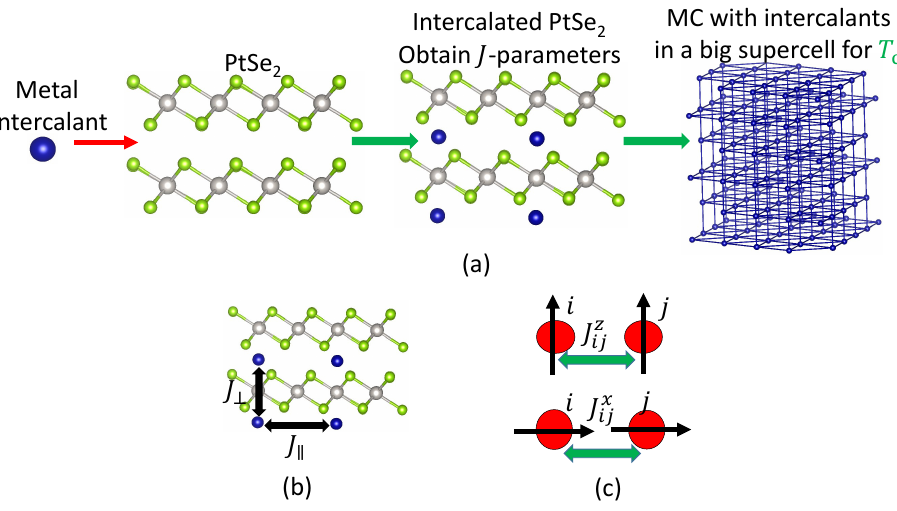
Figure 1. ( a ) The magnetic ions are intercalated in PtSe 2 . ( b ) The exchange parameters in the in-plane ( J (cid:107) ) and in the out-of-plane ( J ⊥ ) direction. ( c ) The J parameters between spins i and j oriented in the in-plane direction ( J x ) and in the out-of-plane direction ( J z ij ij